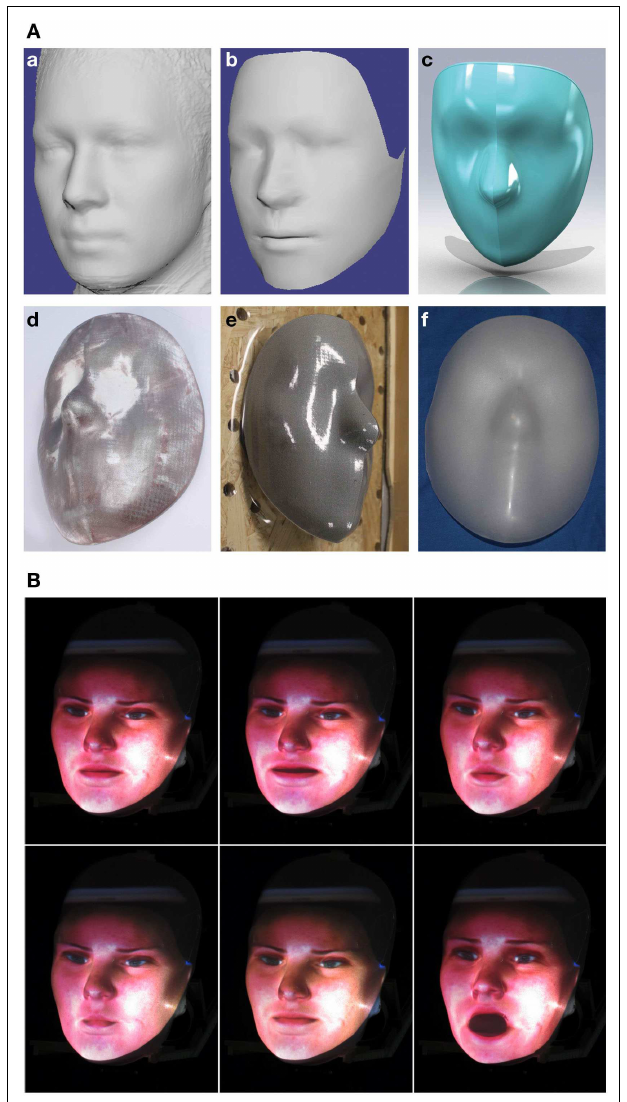
FIGURE 6 | (A) Designing the interchangeable mask: (a) Average face data; (b) The cleaned up dataset; (c) The CAD model of the mask with the correct outer shape to fit into the head’s frame; (d) The 3D-printed mold; (e) The vacuum forming process; (f) The final sprayed mask. (B) Examples of the facial expressions of the avatar projected onto the mask of the